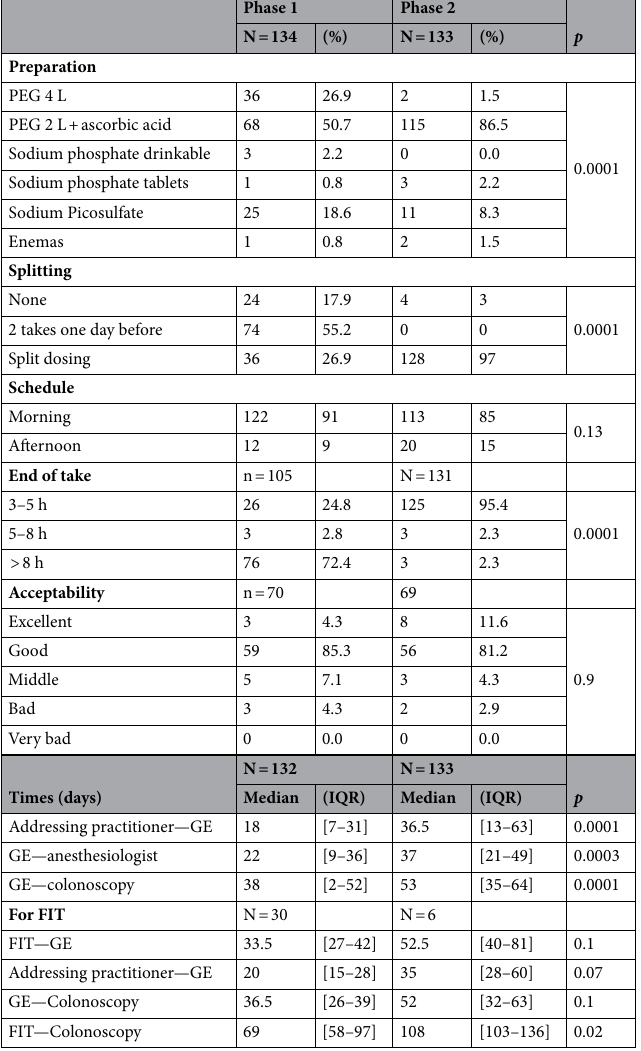
Table 2. Bowel preparations and time to colonoscopy. FIT: Fecal immunological test, GE: gastroenterologist, IQR: interquartile range, PEG: polyethylene